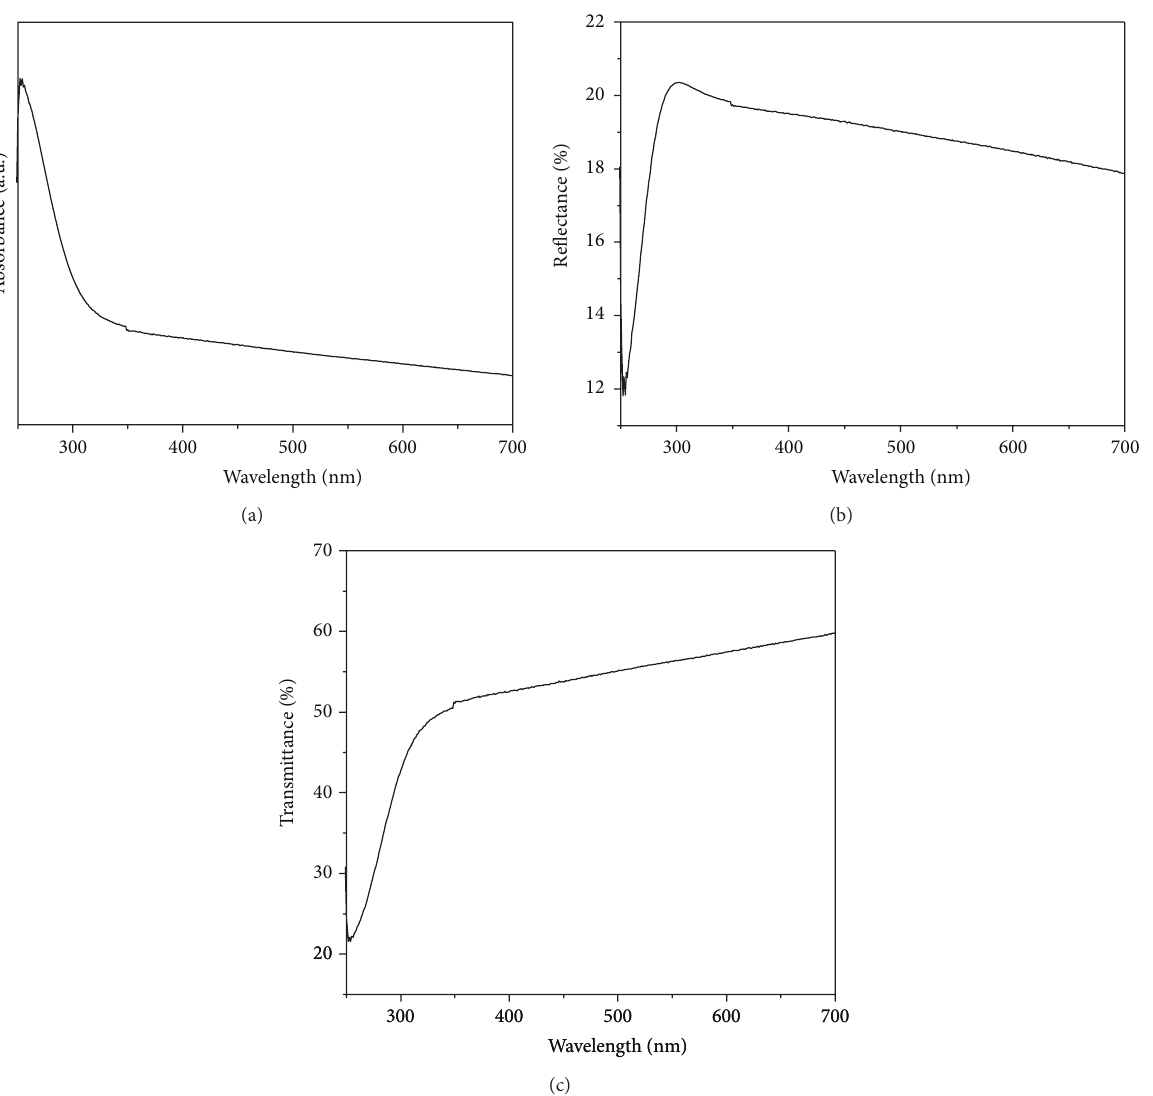
of 𝑛 and 𝑘 from the graph are at 2.8 and 3.2 × 10 −6 , respectively, which occur at the same photon energy 4.75 eV. The peak values of 𝑛 and 𝑘 observed in the UV region indicate that the material can be considered as a good inorganic UV